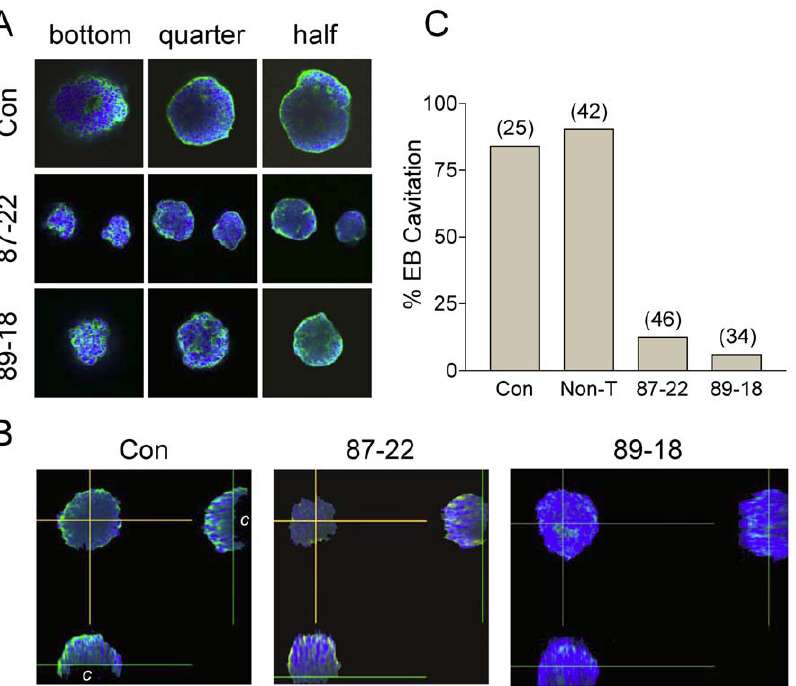
Figure 6. Tim knockdown prevents EB cavitation. EBs were cultured from control and Tim knockdown ES cell lines Lenti:87-22 and Lenti:89-18 for 6 days. Fixed EBs were then stained with DAPI (nuclei; blue) plus Alexa Fluor 488-phalloidin (F-actin; green) and imaged by confocal microscopy using an Olympus Fluoview 1000 confocal microscope. A , Optical sections (5 m m) were taken from the bottom through the middle of the EB where cavitation is the greatest. Images of representative sections are shown of the bottom as well as one-quarter and halfway through the EB. B , Side profiles from merged images reveal cavitation (‘‘c’’) in the control but not the Tim knockdown EBs. C , Bargraph shows the percentage of cavitated EBs formed from the parental mES cell line, mES cells transduced with a nontargeted shRNA lentivector (Non-T) as well as the two Tim knockdown ES cell lines.